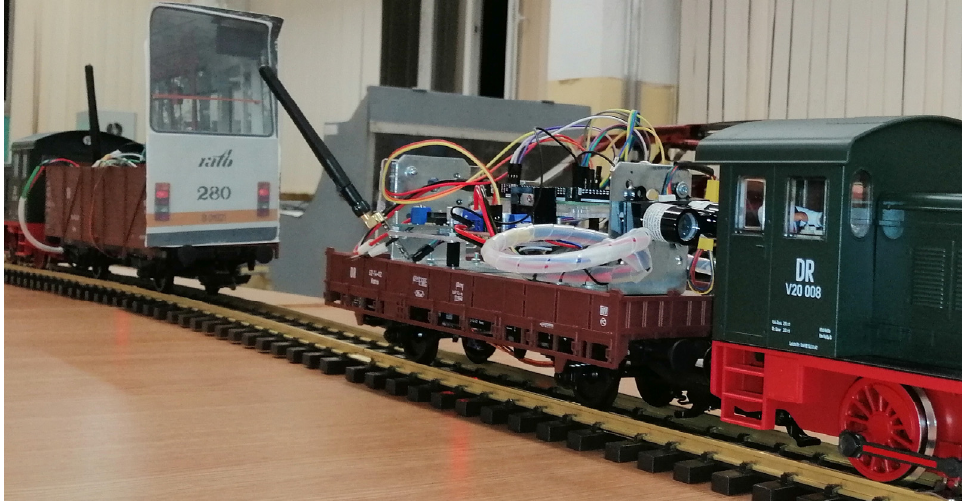
Figure 1. Scaled tram model for indoor testing of long-range LiDAR.